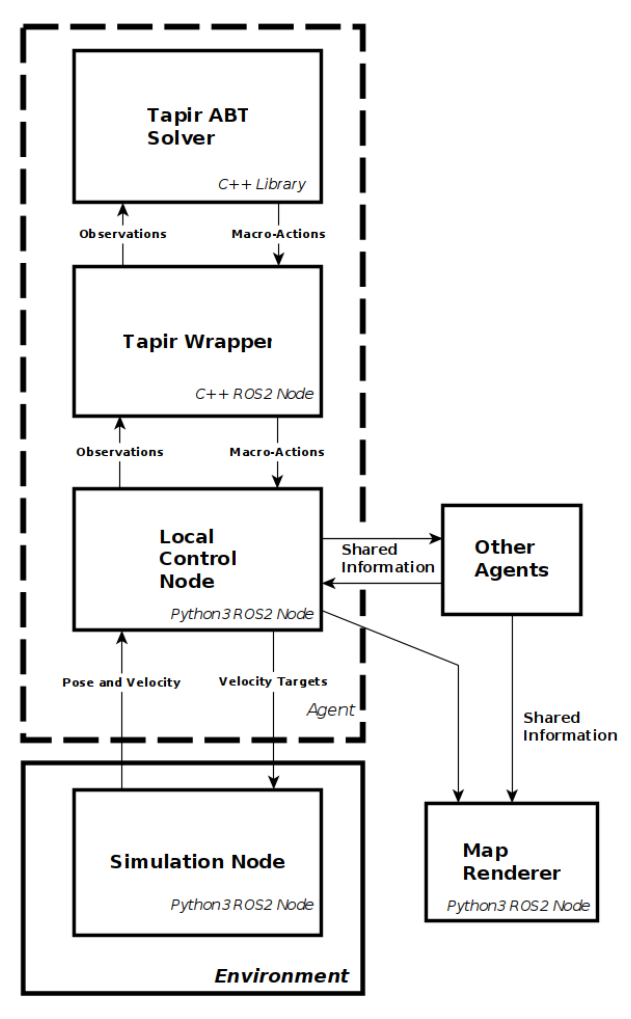
Figure 8. Software